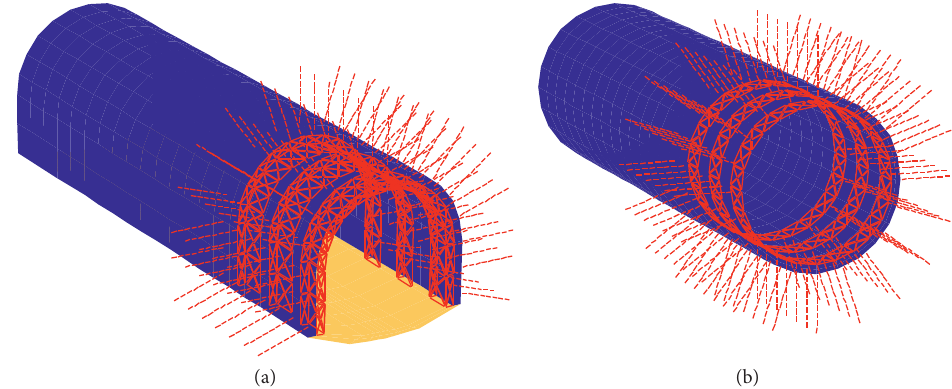
Figure 7: Mechanical model and supporting structure of semicircular arch and circle arch rail roadway.